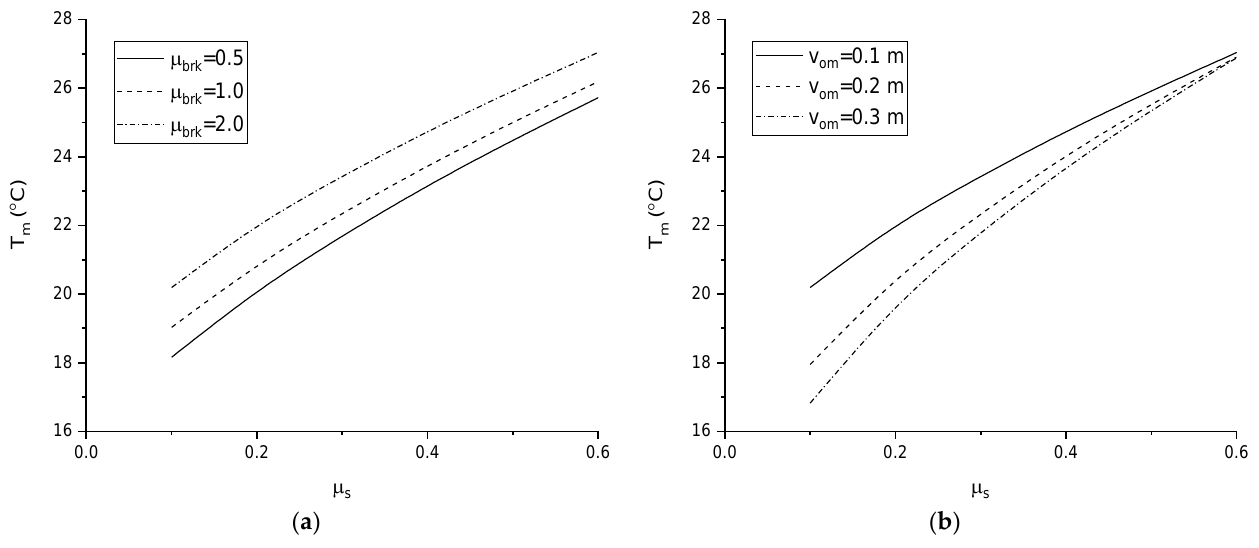
Figure 15. ( a ) Influence of 𝜇 𝑠 on 𝑇 𝑚 with different 𝜇 𝑏𝑟𝑘 ( 𝑣 𝑜𝑚 = 0.1 m). ( b ) Influence of 𝜇 𝑠 on 𝑇 𝑚 with different 𝑣 𝑜𝑚 ( 𝜇 𝑏𝑟𝑘 = 2.0 ).